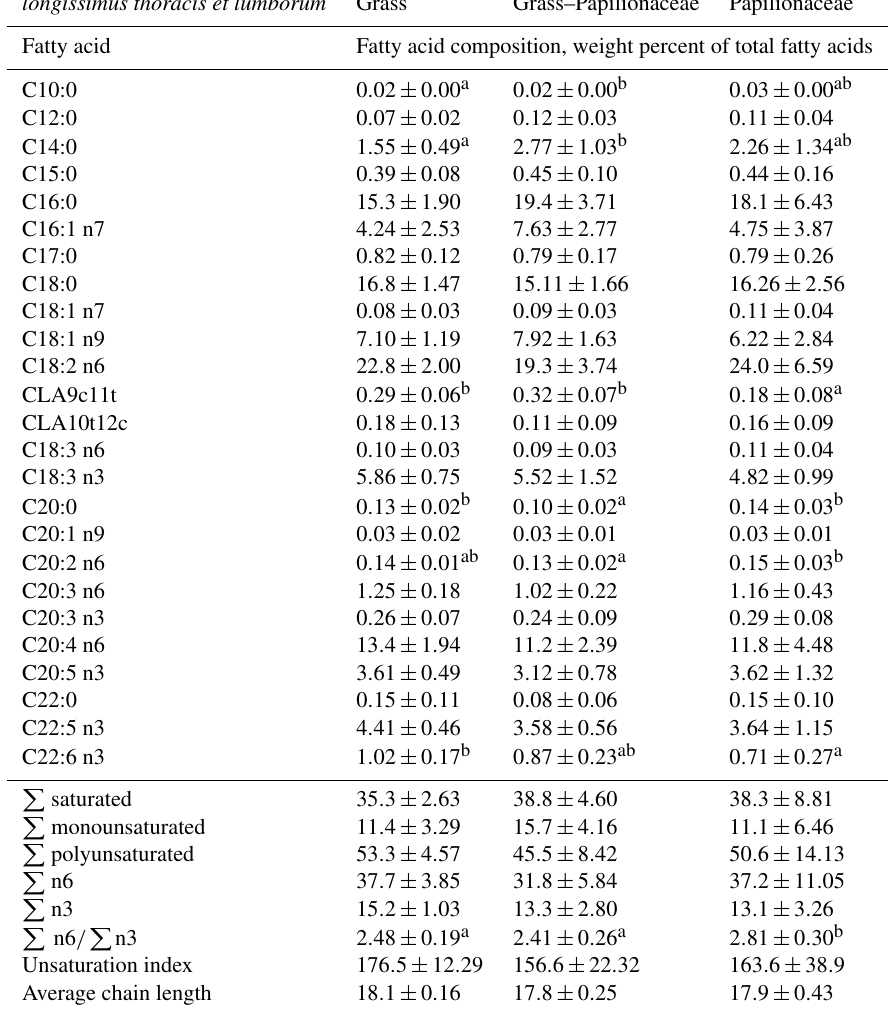
Table 4. Fatty acid composition of the m. longissimus thoracis et lumborum of the three deer groups ( n = 10 / group, means ± SD). longissimus thoracis et lumborum Grass Grass–Papilionaceae Papilionaceae Fatty acid composition, weight percent of total fatty